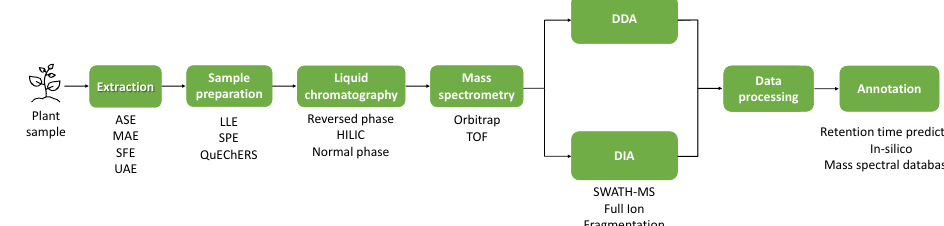
Figure 1. Workflow for non-target screening.